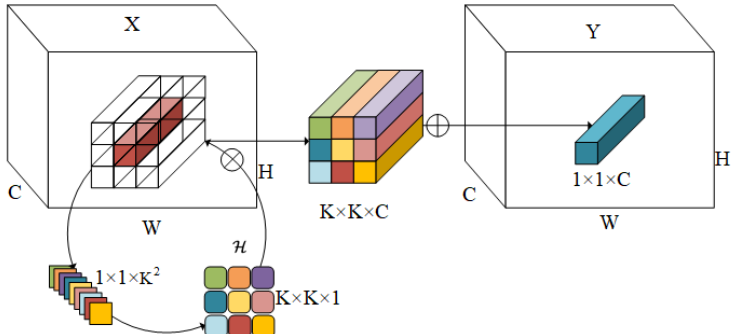
Figure 8. Schematic illustration of involution. The involution kernel H i , j ∈ R K × K × 1 (G = 1 in this